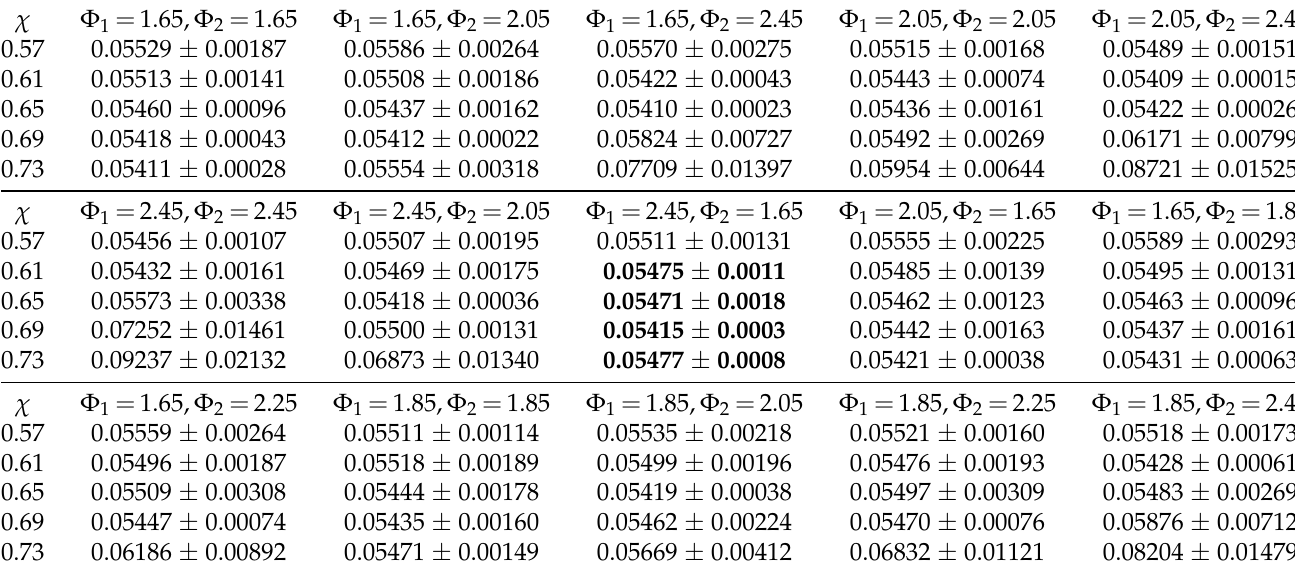
Table 2. The values of mean and standard deviation of f 1 obtained using PSO with I = 100, D = 80, (cid:96) = 12, n = 25 for 50 calculations with the metric d 2